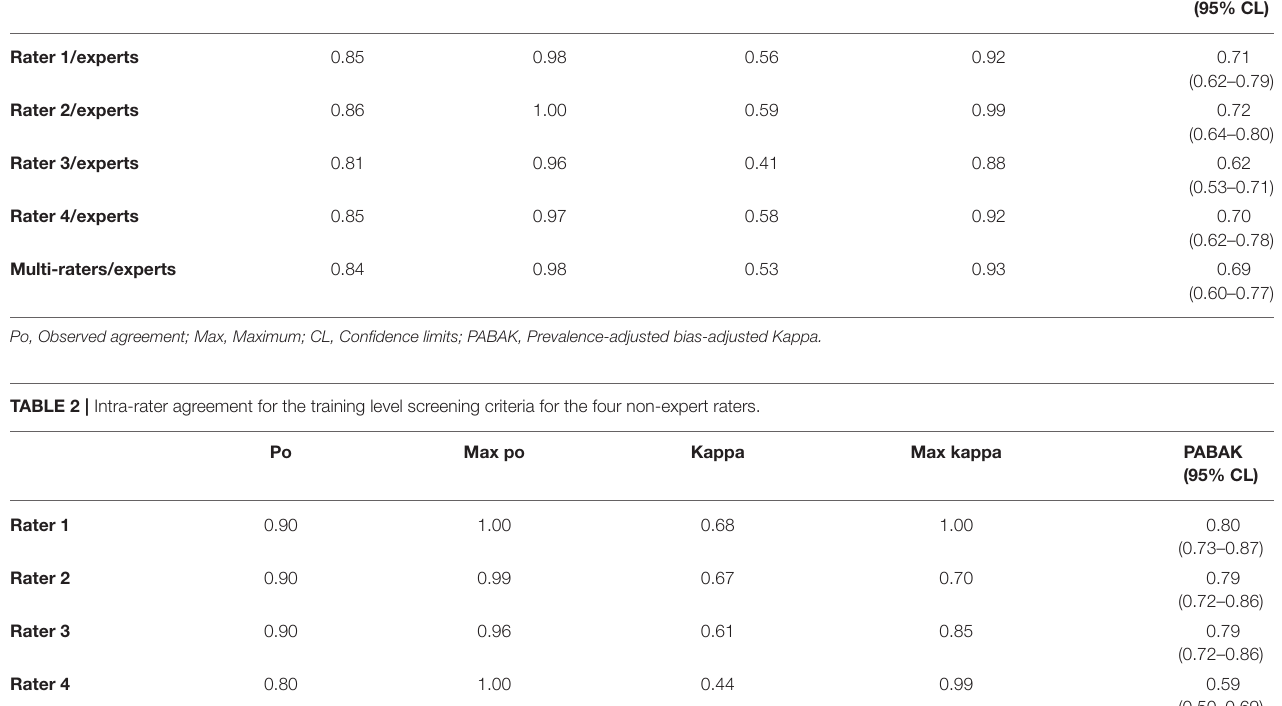
TABLE 1 | Inter-rater agreement for the training level screening criteria between the 4 non-expert raters and the experts. Po Max po